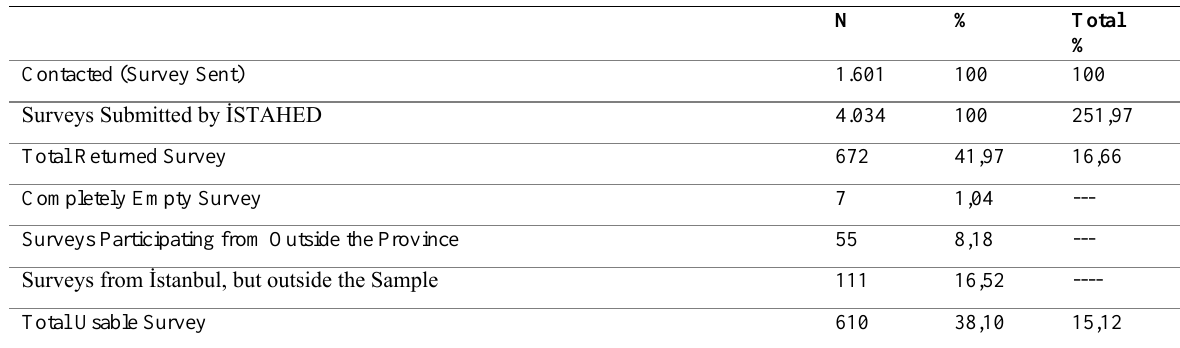
Table 1: Survey Response